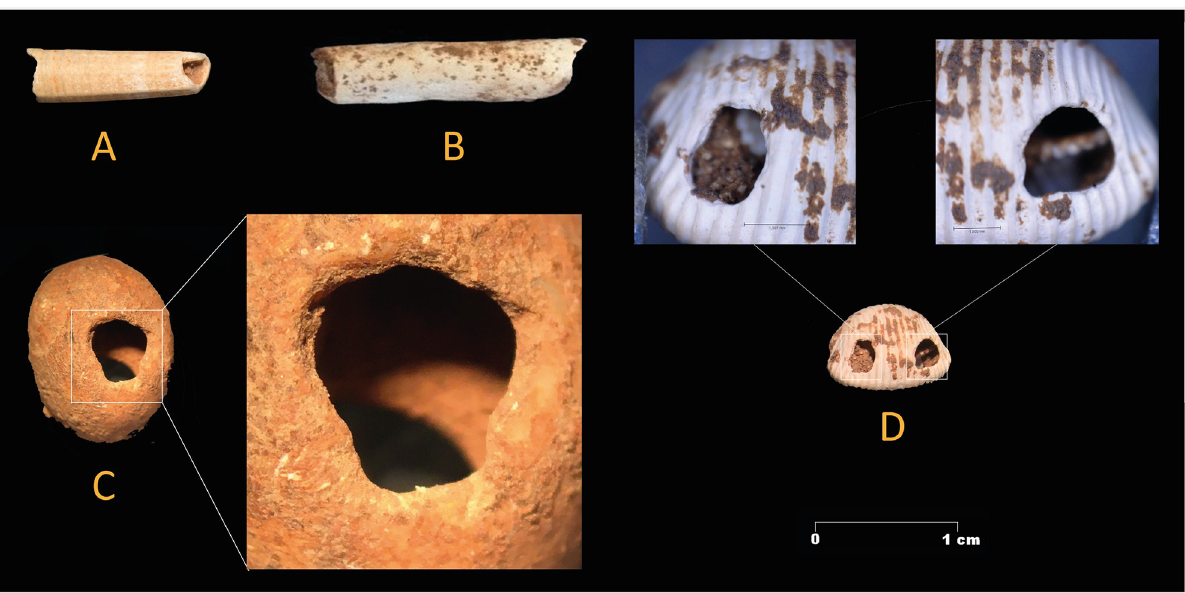
Fig 7. Personal adornment made of mollusks. Left, Gravettian specimens from zone 5, A: Antalis sp.; B: Ditrupa sp.; C: Theodoxus fluviatilis. Right, a double perforated specimen of Trivia monacha found in a disturbed context in zone 2.